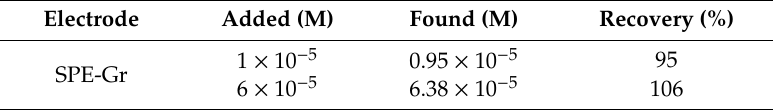
Table 3. Determination of 8-OHdG with SPE-Gr in spiked saliva